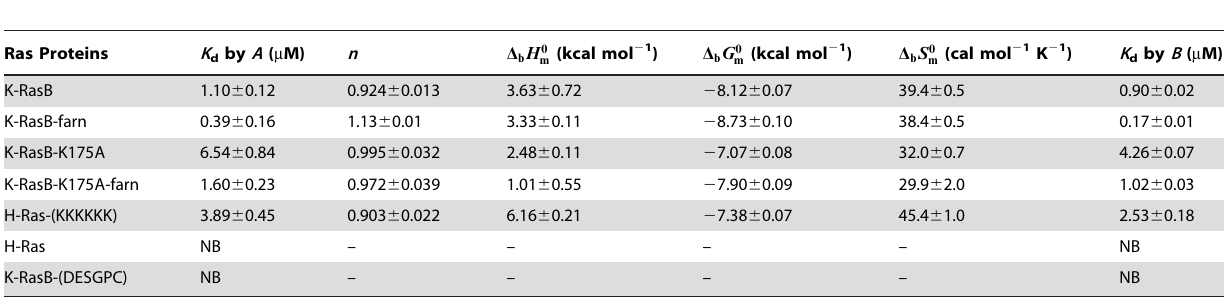
Table 1. Thermodynamic parameters for the binding of Ras proteins to Ca 2 + /CaM as determined by ITC ( A ) and dansyl-CaM fluorescence titration ( B ) at 25.0 u C.